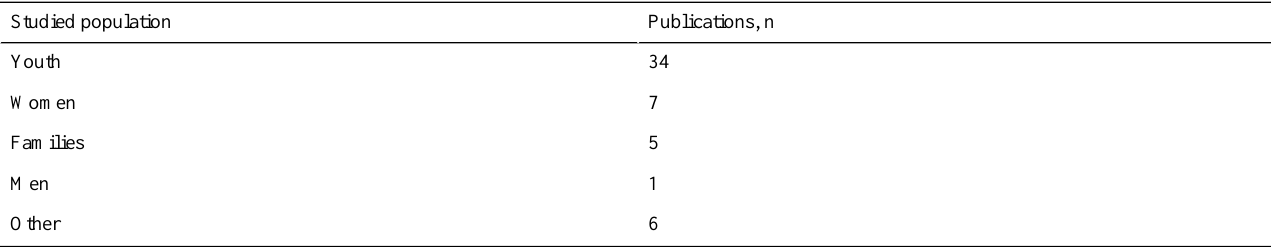
Table 5. Distribution of publications per studied population (N=53).